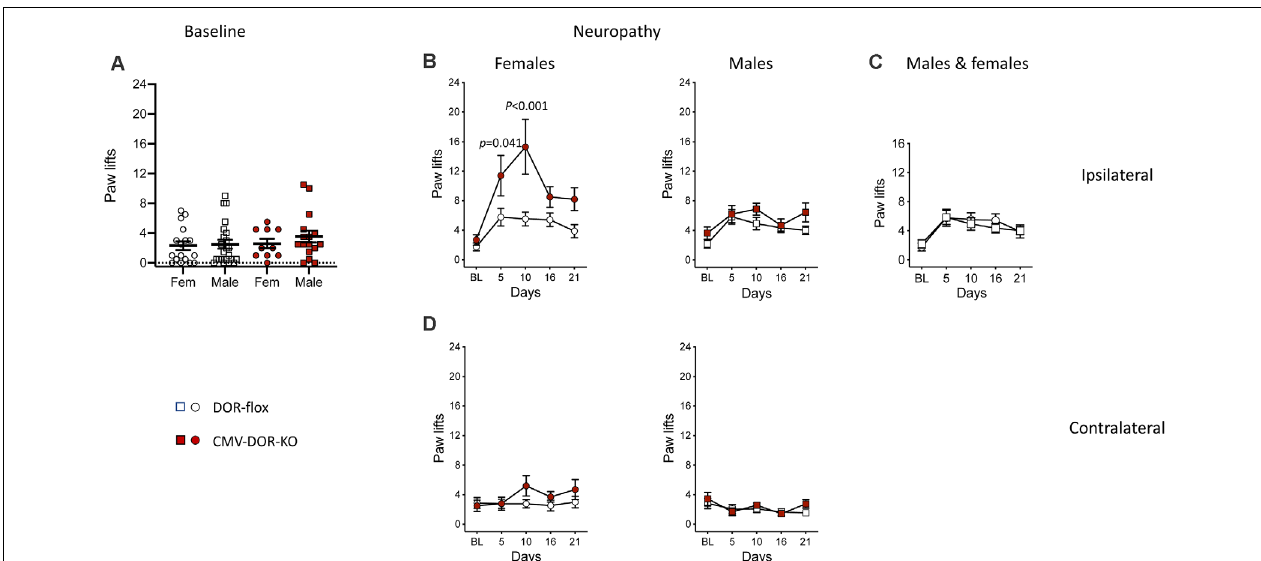
FIGURE 5 | Cold neuropathic allodynia was aggravated in CMV-DOR-KO female mice. (A) Baseline paw responses on the cold plate were similar in CMV-DOR-KO and control DOR-flox mice (Two-way ANOVA). (B) Paw responses at the ipsilateral side. In females, cold allodynia was augmented in CMV-DOR-KO mice as compared to DOR-flox mice, and genotype difference was significant on individual days 5 and 10. In males, allodynia was comparable in the two genotypes. (C) Cold allodynia in DOR-flox females and males showed no sex effect. (D) There was cold allodynia at the contralateral sides in females and males of both genotypes. n = 17 DOR-flox females, n = 10 CMV-DOR-KO females, n = 23 DOR-flox males and n = 16 CMV-DOR-KO males. Two-way repeated measures ANOVA followed by Sidak’s multiple comparison test. P -values for the difference between genotypes are shown when significant ( p < 0.05). Data are expressed as mean ± SEM. See also Supplementary Table 5 for